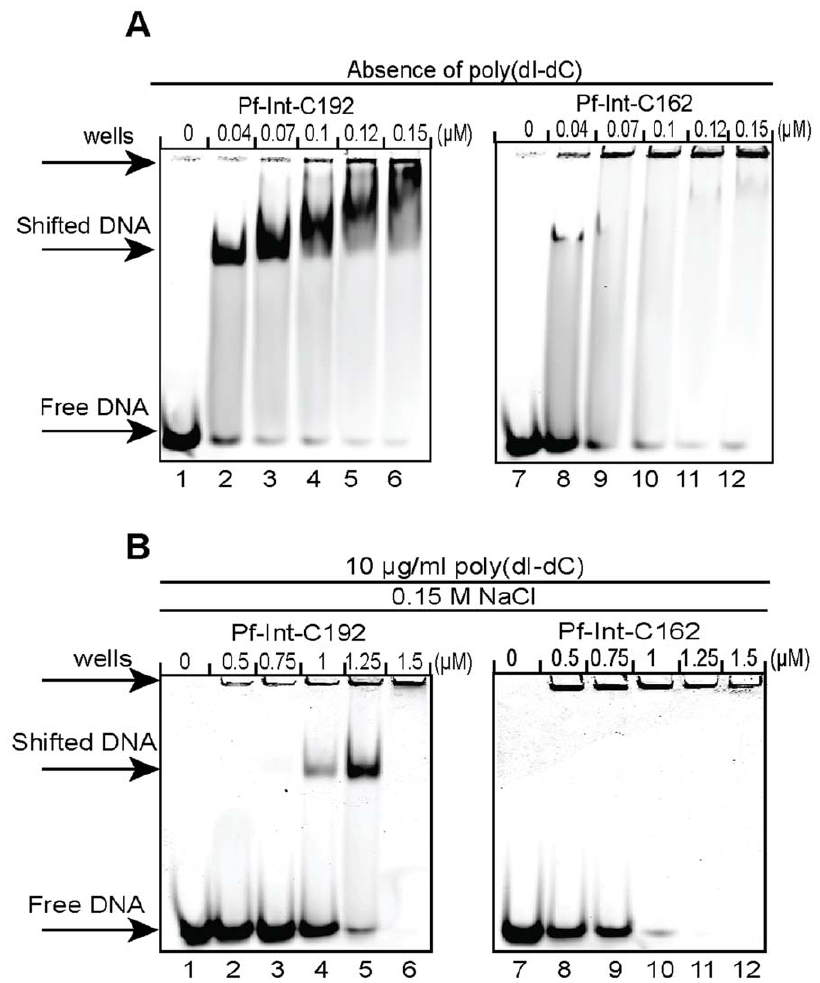
Figure 5. Characterization of Pf-Int interaction with DNA targets. 10 nM of labeled Selex8-DNA were incubated with increasing amounts of Pf-Int-C192 (lanes 1 to 6) and Pf-Int-C162 (lanes 7 to 12) A ) in absence of poly (dI-dC) and B ) in the presence of 10 m g/ml of poly (dI-dC).